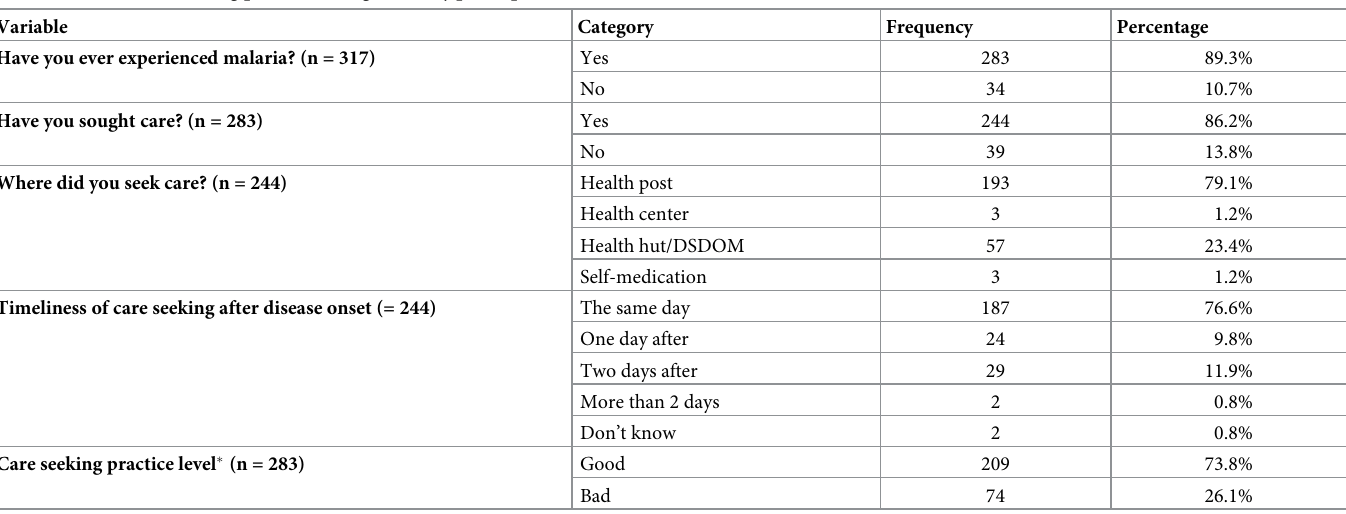
Table 5. Malaria care seeking practice among the study